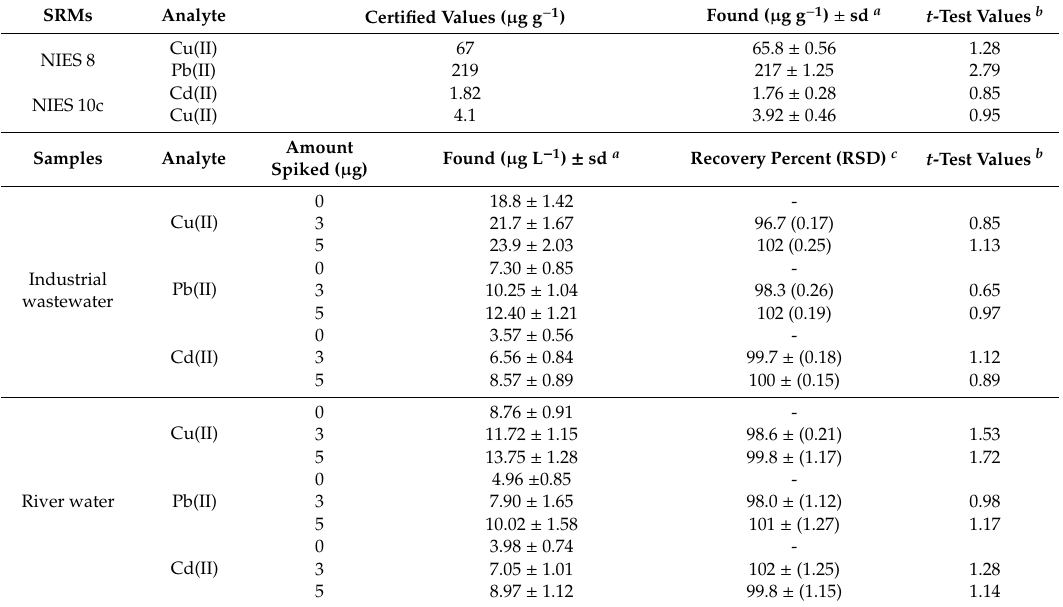
Table 7. Validation of the proposed methodology by analyzing Certified reference material (CRMs) and real water samples after column preconcentration (column conditions: sample volume 100 mL, flow rate 8 mL min − 1 , eluent 5 mL H 2 SO 4